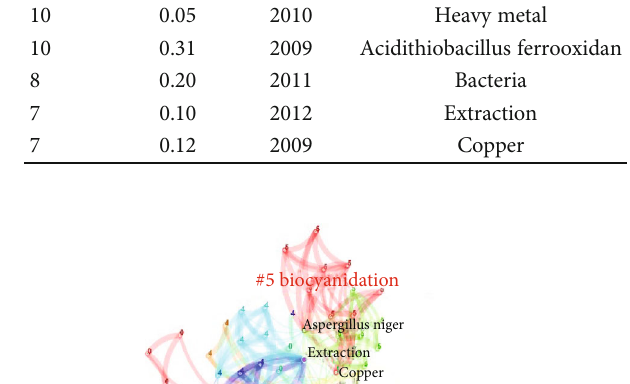
Figure 3: Research hotspots of bioleach technology (keywords co- occurrence).